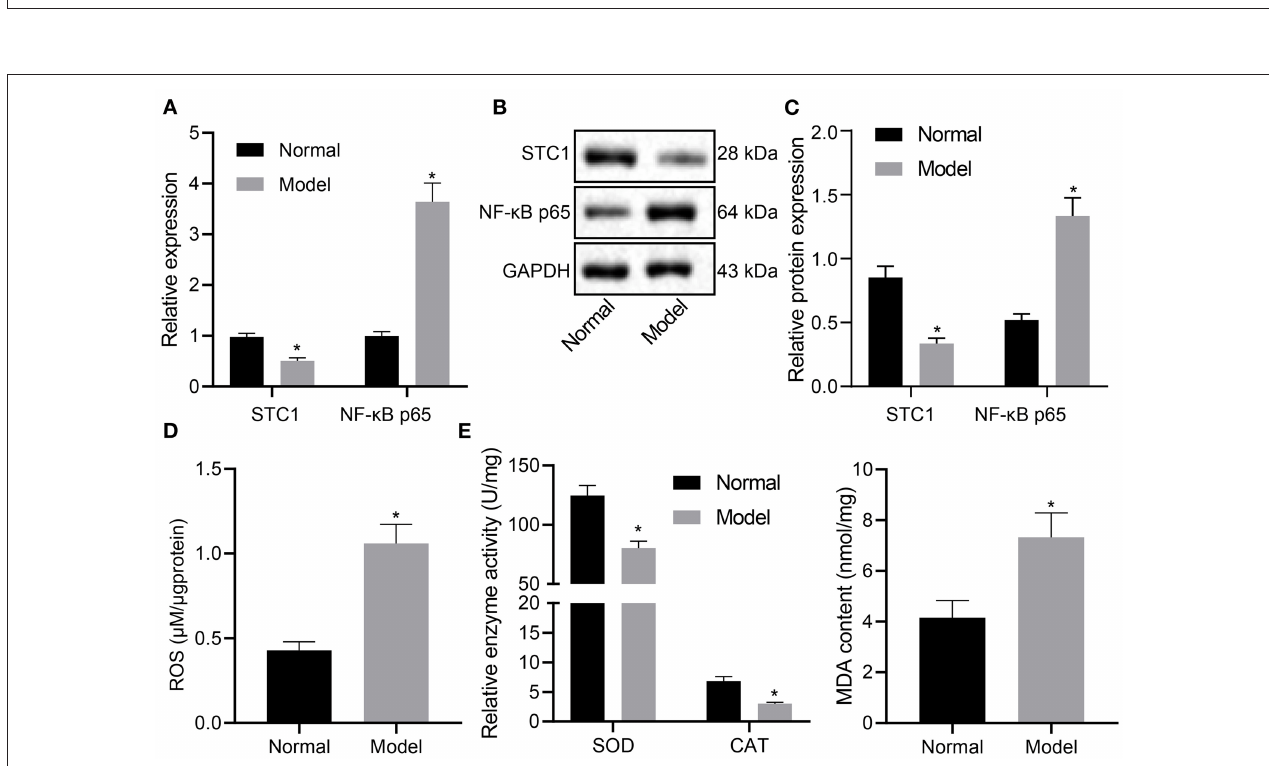
FIGURE 2 | STC1 is underexpressed while ROS/NF- κ B signaling pathway is activated in enhances rats with depression-like behaviors. (A) STC1 and NF- κ B p65 mRNA expression in the hippocampal tissues of rats with depression-like behaviors determined by RT-qPCR. (B) STC1 and NF- κ B p65 protein expression in the hippocampal tissues of rats with depression-like behaviors measured by Western blot assay. (C) Quantitative analysis of STC1 and NF- κ B p65 protein expression. (D) ROS production in the hippocampal tissues of rats with depression-like behaviors. (E) SOD, CAT, and MDA levels in hippocampal tissues of rats with depression-like behaviors. * p < 0.05. n =